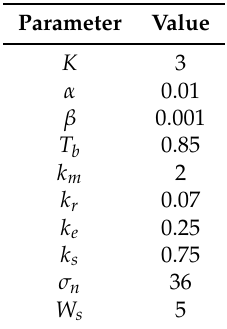
Table 4. Optimized parameters set for canoe video.